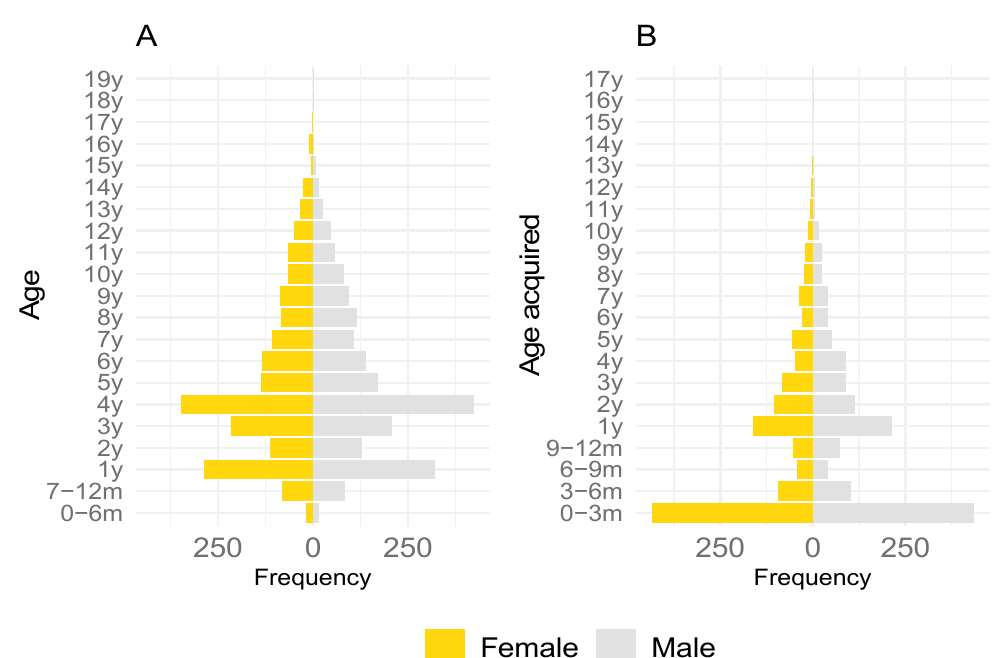
Figure 1. Age ( A ) and age acquired ( B ) population pyramids for participating dogs. Note, in general category labels range from greater the value given to less than or equal to the subsequent value, so “1y” indicates an age >1 year and ≤ 2 years, likewise “3–6 m” indicates an age >3 months and <6 months.